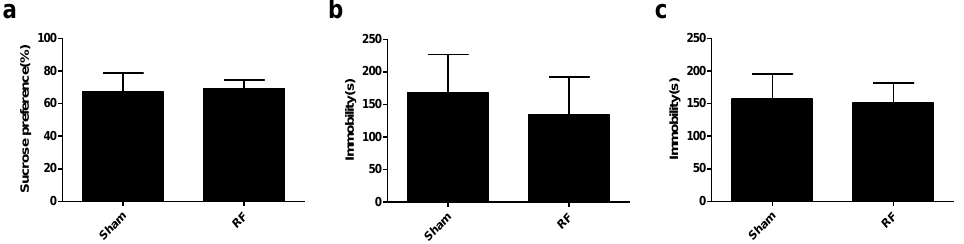
Figure 4. Effects of RF field exposure on depression-like behaviors. ( a ) the index of the SPT (t = 0.501, df = 18, P = 0.622), ( b ) the immobility time of the TST (t = 1.438, df = 18, P = 0.168), ( c ) the immobility time of the FST (t = 0.417, df = 18, P = 0.682). All data are presented as mean ± SD. No significant difference was observed between the sham and RF groups ( P > 0.05).